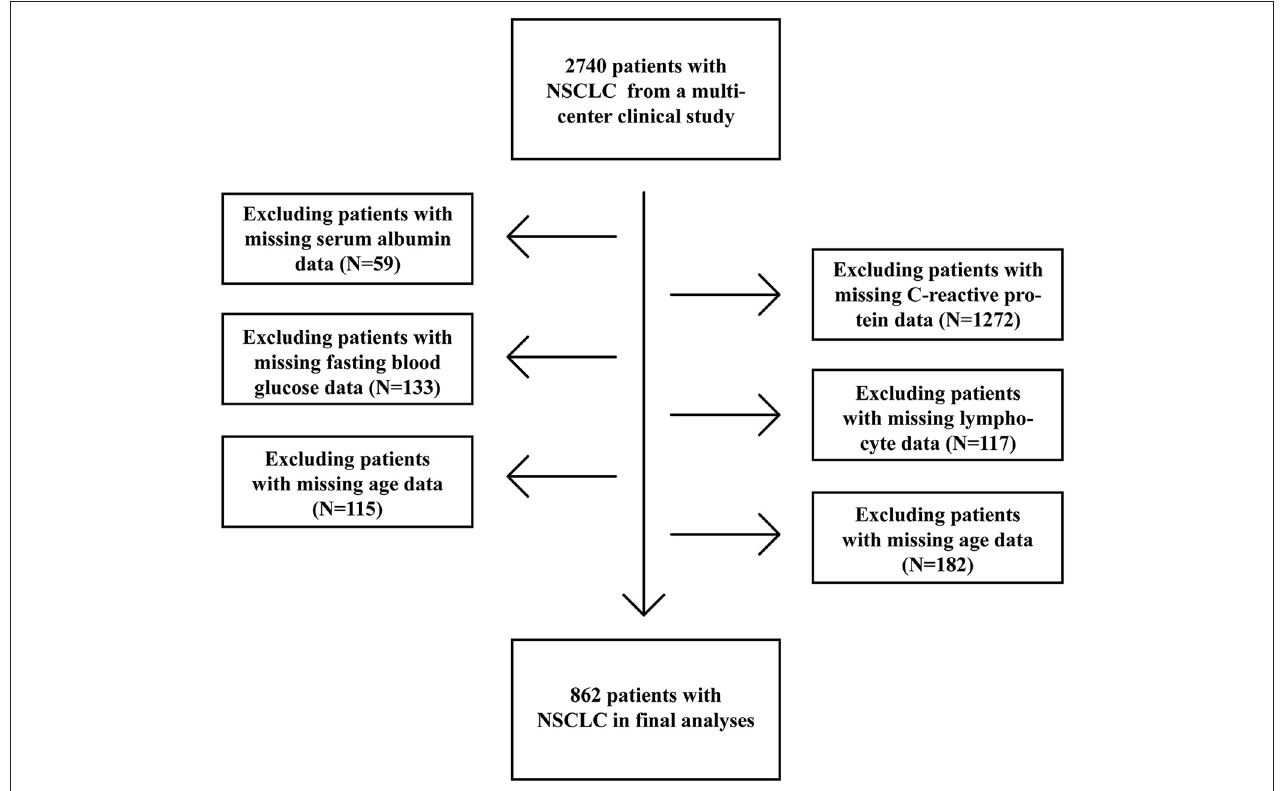
FIGURE 1 | Procedures for selection of study participants with non-small cell lung cancer (NSCLC) from a multi-center clinical